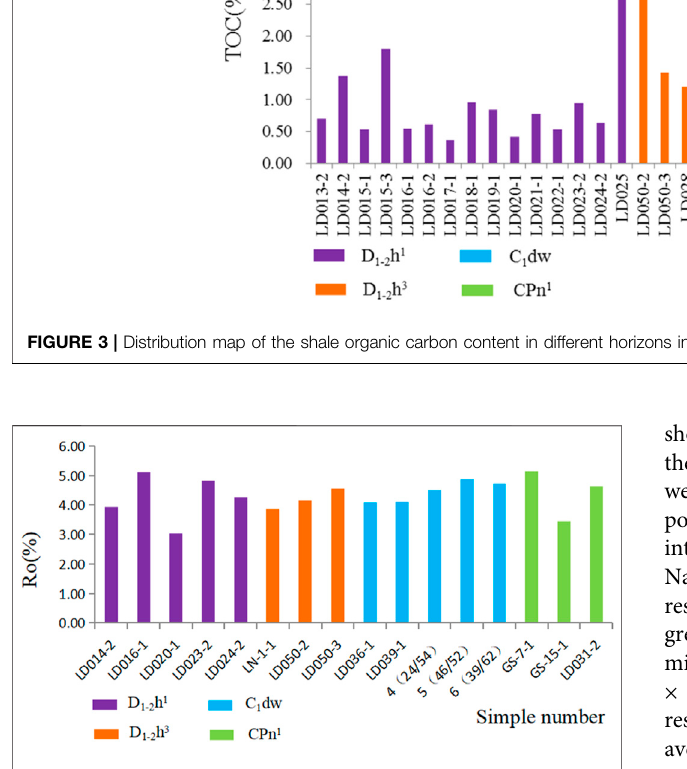
FIGURE4| Distributionmap ofvitrinitere fl ectance(Ro)indifferentlayers of shale in the Qiannan area.